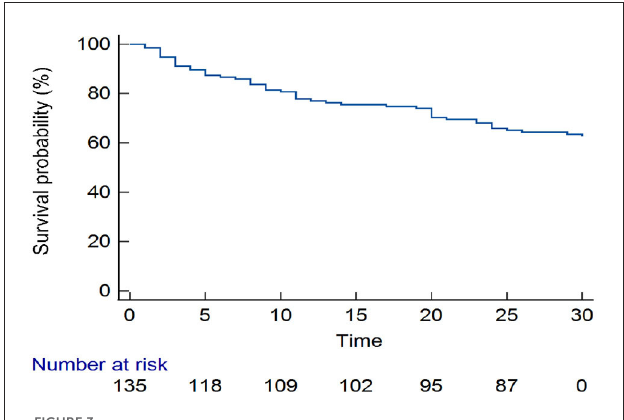
FIGURE3 Kaplan–Meier curve estimating overall survival experience.